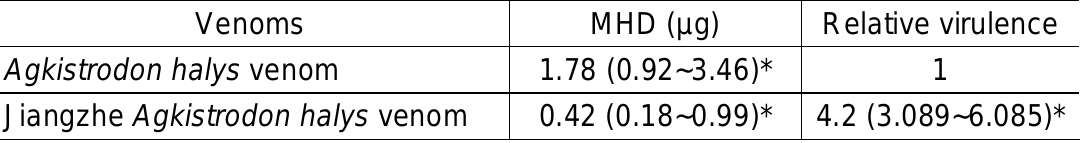
Table 2: Minimum Hemorrhagic Doses (MHD) of venoms and their relative virulence.